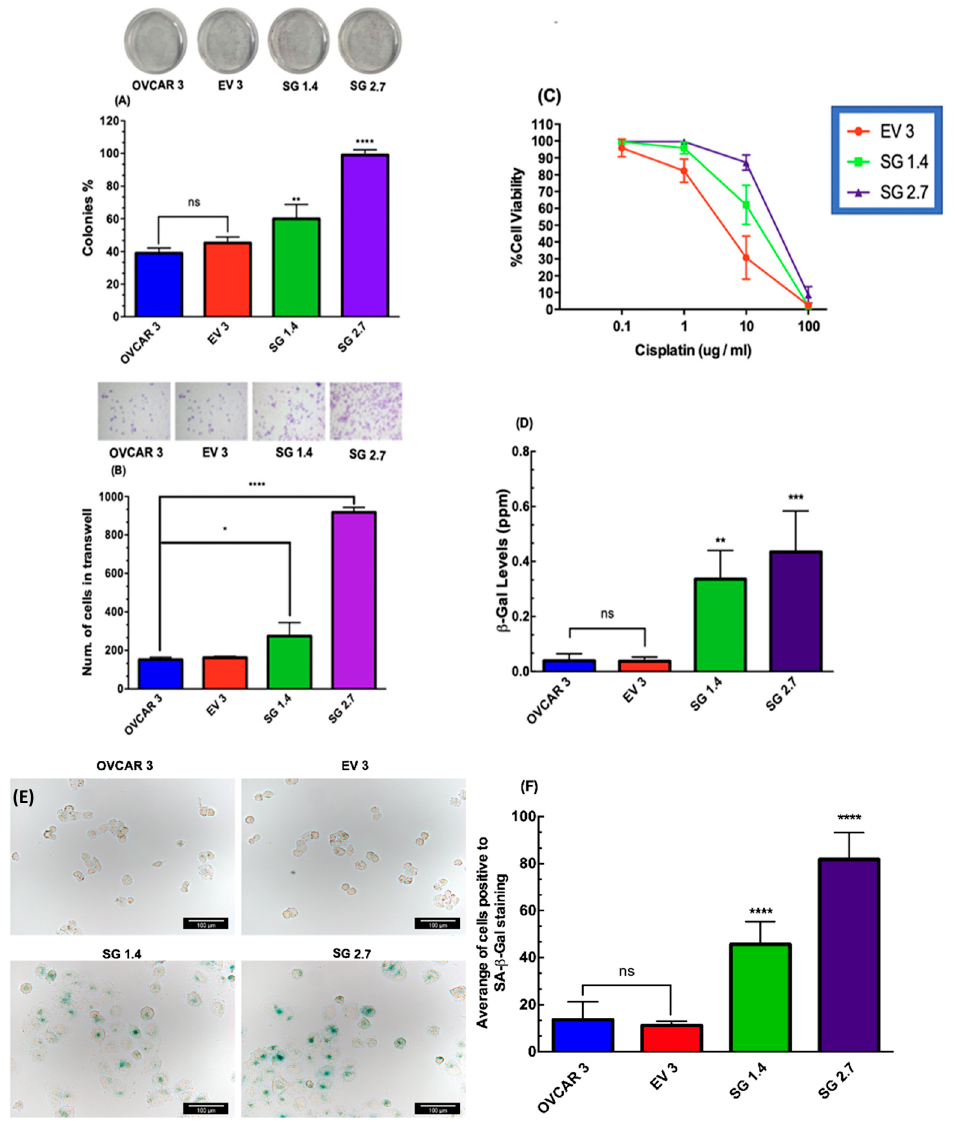
Figure 3. Effect of RBPMS knockdown on cell growth, proliferation, invasion capacity, and senescence: ( A ) Colony formation assay. Percentages of clonogenicity were calculated relative to EV cells. ( B ) Cell invasion assay. Percentages of invasion were calculated relative to EV cells. ( C ) EV and SG1 and SG2 clones (3 × 10 4 cell/mL) were exposed to different concentrations of cisplatin for 72 h. Cell viability values were calculated relative to EV cells. Averages ± SEM are shown for three independent experiments. * p < 0.05, ** p < 0.01, *** p < 0.001, **** p < 0.0001. ( D ) Cells (1 × 10 4 cells/mL) were plated in Petri diches. Twenty-four hours later, cells were rinsed with PBS, and protein extracts were prepared and diluted at a 1 µg/mL protein concentration. Senescence-associated β -galactosidase activity (SA- β -gal) was assessed via fluorescence. β -galactosidase levels were calculated relative to empty vector cells. Averages ± SEM are shown for three independent experiments. ( E , F ) Representative images and quantification of SA- β -Gal-stained cells. Images scale bar: 100 µm (bars: six microscopic fields per condition). ** p < 0.01, *** p < 0.001, **** p < 0.0001.